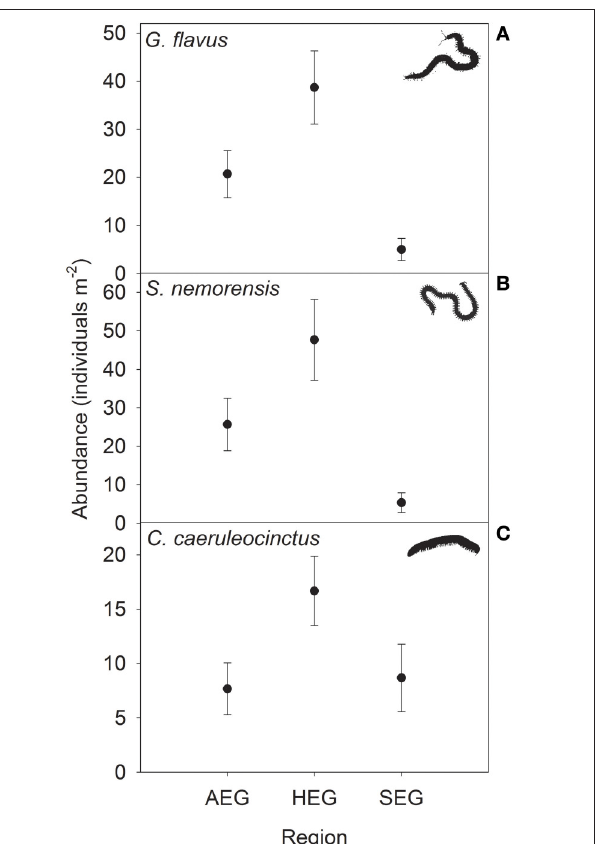
FIGURE 1 | Relationship between land-use intensity and the abundance of the three detritivorous mesofauna species Eupelops occultus (A), Tectocepheus velatus (B), and Isotoma viridis (C) in three study regions (AEG, dotted-dashed lines; HEG, solid lines; SEG, dashed lines; see Table 1 for location and abbreviation of regions).